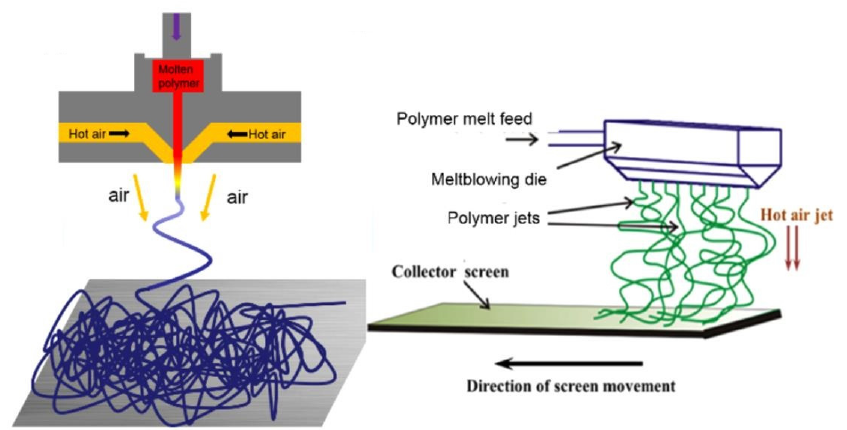
Figure 2. The setup for the melt-blown process. (Reprinted with permission from [13]. Copyright 2019 ACS Publications.).